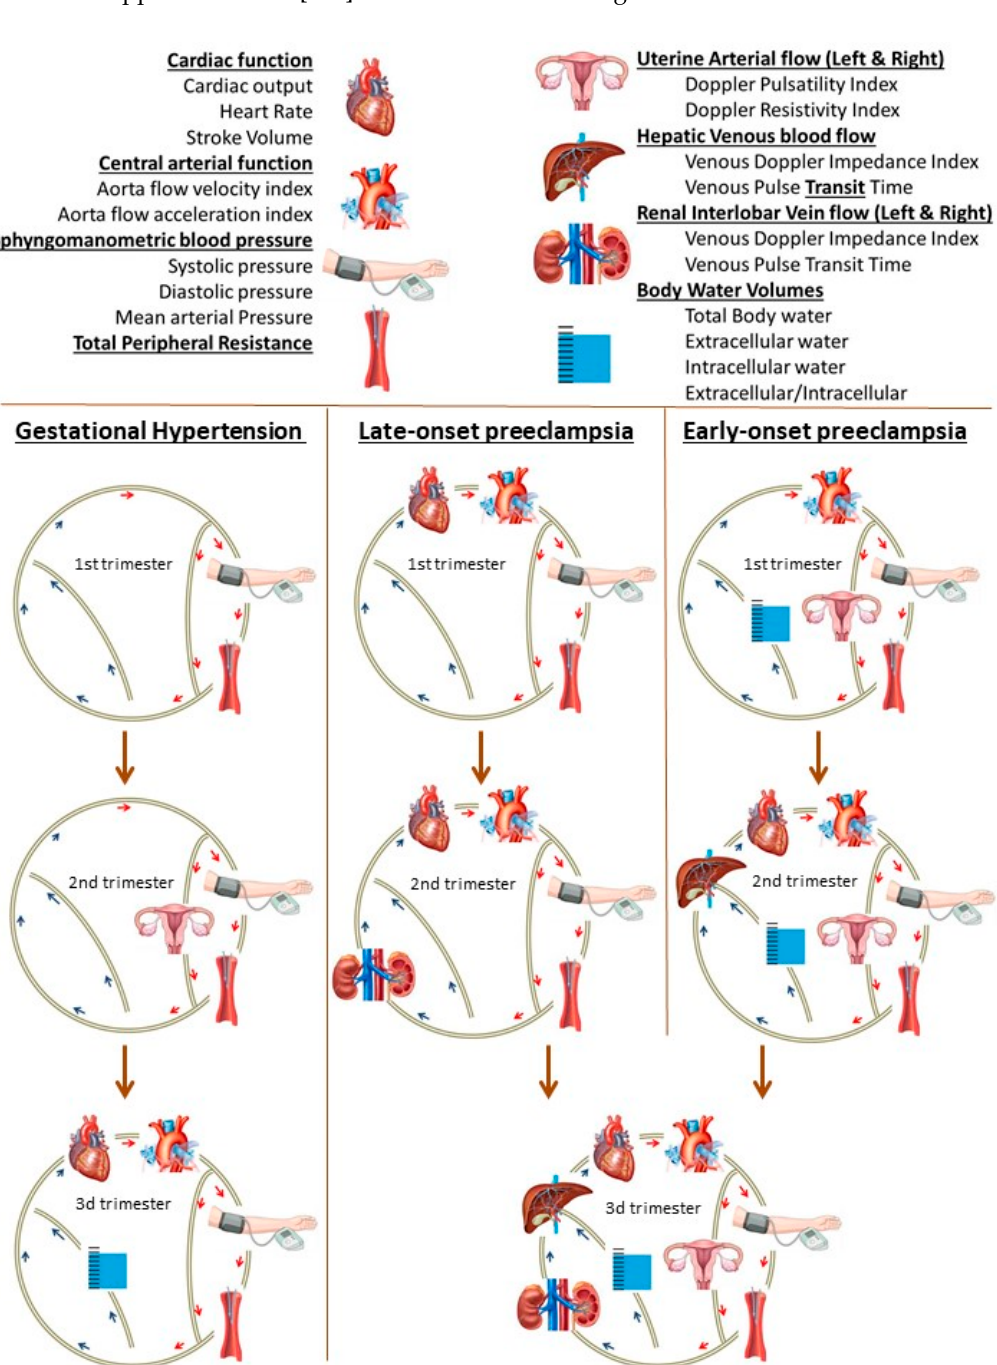
Figure 3. Graphical presentation of the gradual deterioration of the maternal circulation from first to third trimester in pregnancies, destined to develop gestational hypertension, early- or